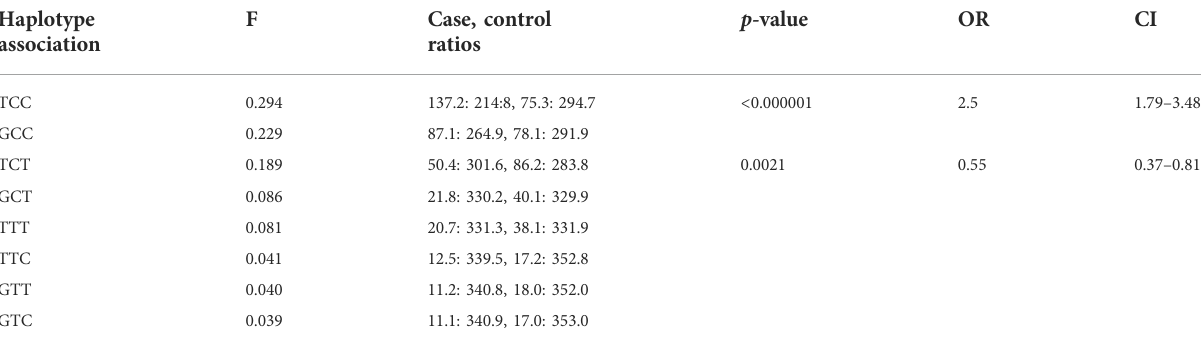
TABLE 4 Haplotype associations between TLR1 (rs5743618) and TLR2 (rs1816702 and rs4696483) polymorphism. Haplotype